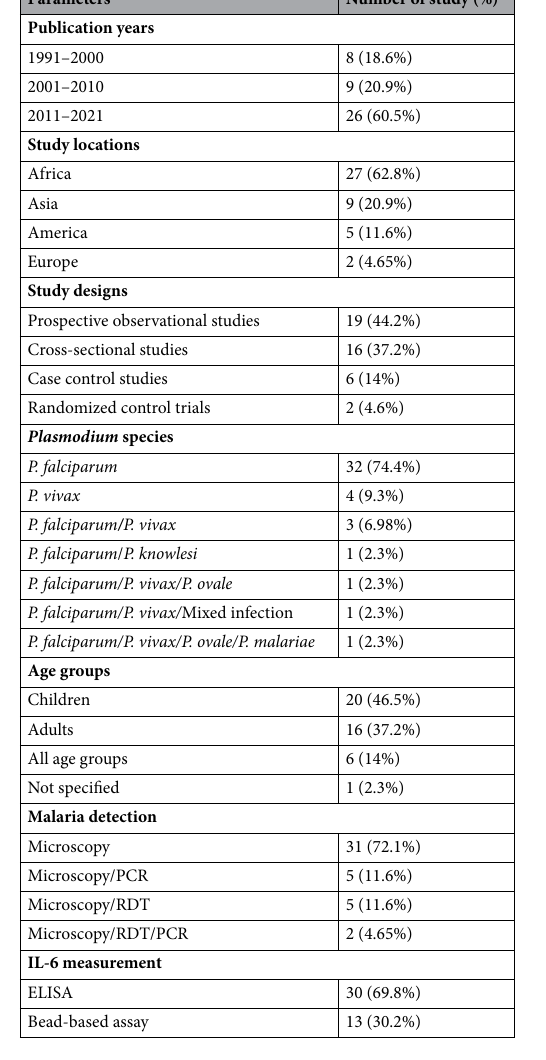
Table 1. Characteristics of the included studies. IL-6 interleukin-6, ELISA enzyme-linked immunosorbent